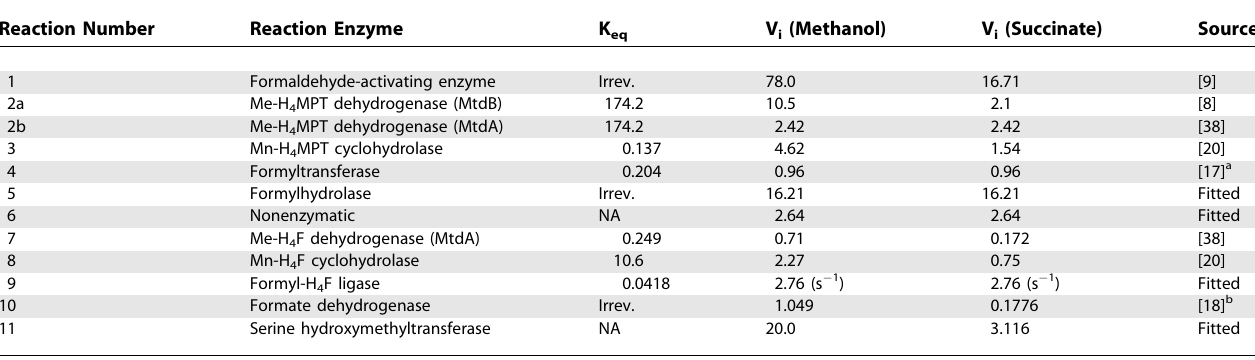
Equilibrium constants are all dimensionless, except for reaction 9, which has units of mM. Units for kinetic constants are mM/sec unless otherwise noted. a The literature value for this constant is 0.71 mM/s. A small adjustment was required to fit the data. b Constants of twice the literature values were assumed, due to the presence of multiple formate dehydrogenases. H 4 F, tetrahydrofolate; H 4 MPT, tetrahydromethanopterin; me-H 4 F, methylene-H 4 F; me-H 4 MPT, methylene-H 4 MPT; MFR, methanofuran; mn-H 4 F, methenyl-H 4 F; mn-H 4 MPT, methenyl-H 4 MPT; Irrev., irreversible; NA, not applicable. DOI: 10.1371/journal.pbio.0030016.t002 PLoS Biology |